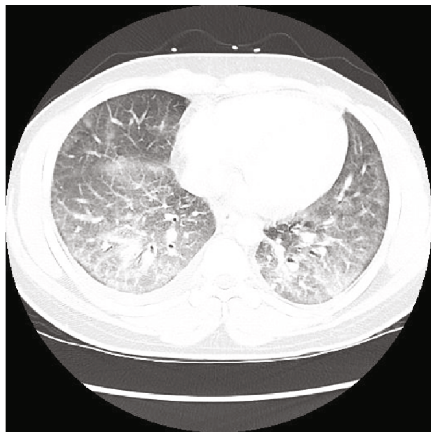
Figure 2: Chest CT: bilateral mixed interstitial and ground-glass in fi ltrates. Lower lobe predominance. Small right pleural e ff